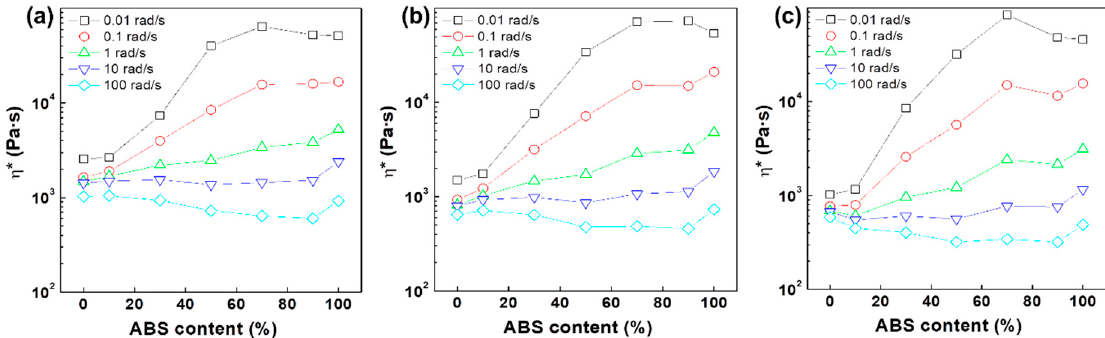
Figure 1. Change of viscosity of PC/ABS blends at given frequencies; measured at ( a ) 240, ( b ) 250 and ( c ) 260 °C.